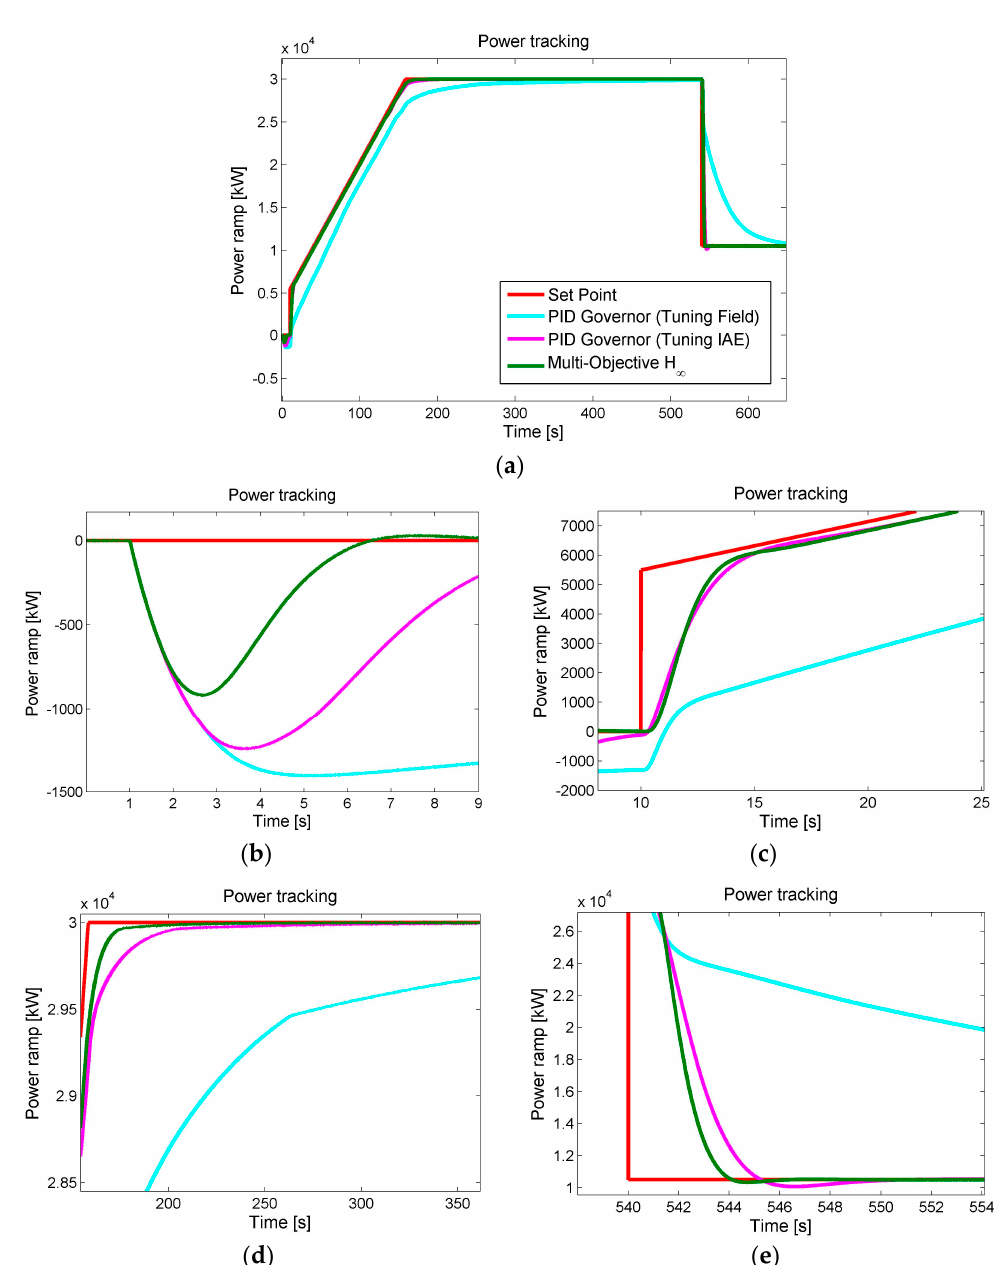
Figure 22. Closed-loop power reference tracking of the perturbed nonlinear system. Comparison between the multi-objective H ∞ robust controller and the PID Governor tuned with IAE settings and site settings: ( a ) Complete view; ( b ) Disturbance rejection in the initial stage; ( c ) Ramp command start; ( d ) Steady-state at 30 MW; ( e ) Power profile in the final stage.